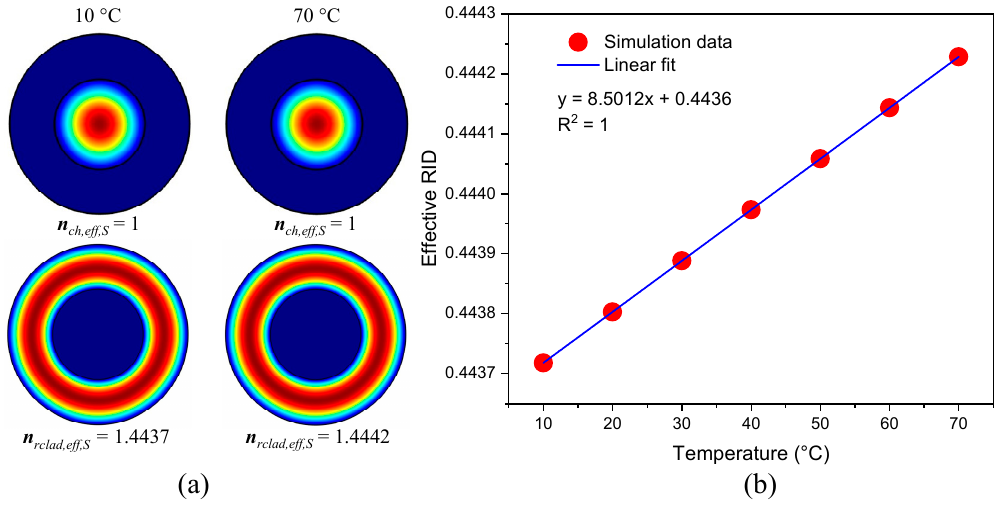
Figure 3. ( a ) Mode field distribution of the fundamental and cladding modes at two different temperatures (10 and 70 °C), ( b ) Simulation of the variation of the effective refractive index difference (ERID) at different temperatures.